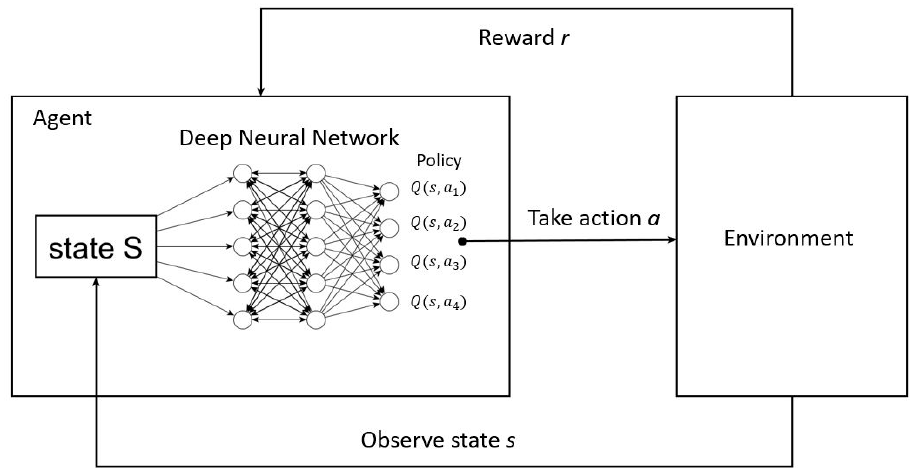
Figure 18. Interaction between the DQN and the environment.